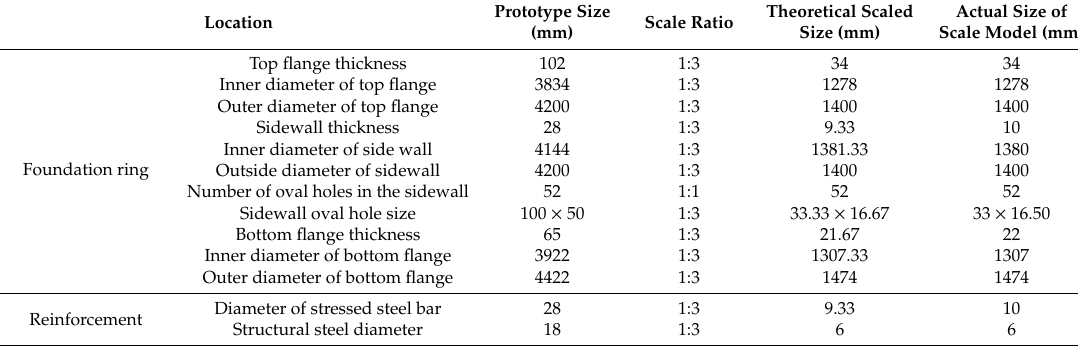
Table 3. Calculation of foundation ring and